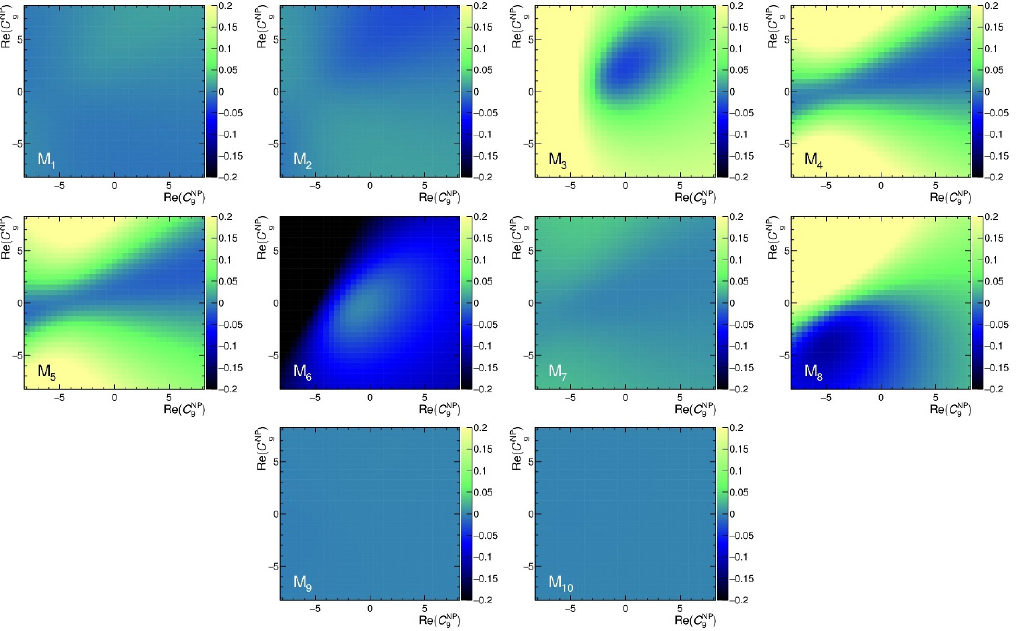
+ (cid:22) (cid:0) decay from their SM central 1 { M 10 of the (cid:3) b ! (cid:3) (cid:22) ). 9